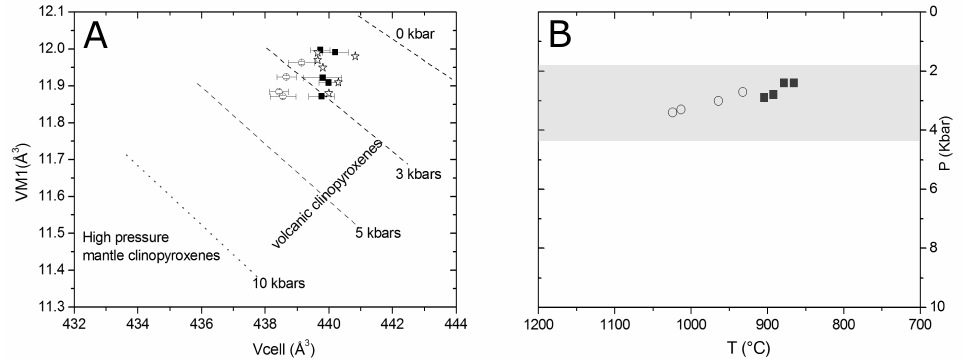
Figure 8. ( A ) Single-crystal clinopyroxenes geobarometry plot. Volumes of M1 octahedron and unit cell for the host- (full square) and enclaves-clinopyroxenes (open circle) and clinopyroxene from [37]. The high pressure field boundary is defined by the literature clinopyroxene from spinel-lherzolite rocks [48]. Pressure isobars lines are from [15]. ( B ) P-T diagram for host-enclaves pyroxene pairs calculated on the basis of sample geochemistry. See text for explanation. Symbols as described